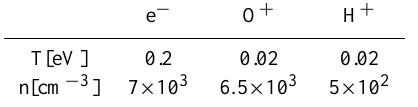
Fig. 5. Solution of Eq. (4) and the derived quantities obtained for 6 P given by Eq. (2) with 6 P 0 = 0 . 5 and various profiles of 8 m (see Fig. 2) obtained for five different bulk velocities on the LLBL side of the TD. The values of V LLBL corresponding to each color are given in the legend of panel (d). The panels show: (a) overall solution of the field-aligned potential drop; (b) detail of the profile of the magnetospheric (solid line) and ionospheric (dashed line) electric field; shown is the component normal to the arc; the solid arrows illustrate the orientation of the electric field suggesting the regions where the field is convergent or divergent; (c) detail of the profile of the field-aligned current density; (d) detail of the profile of the flux of precipitating energy; (e) detail of the profile of the height-integrated Pedersen conductivity. Table 2. Reference density and temperature of the ionospheric species considered in the current-voltage relationship. The charge densities were adjusted such that charge neutrality is